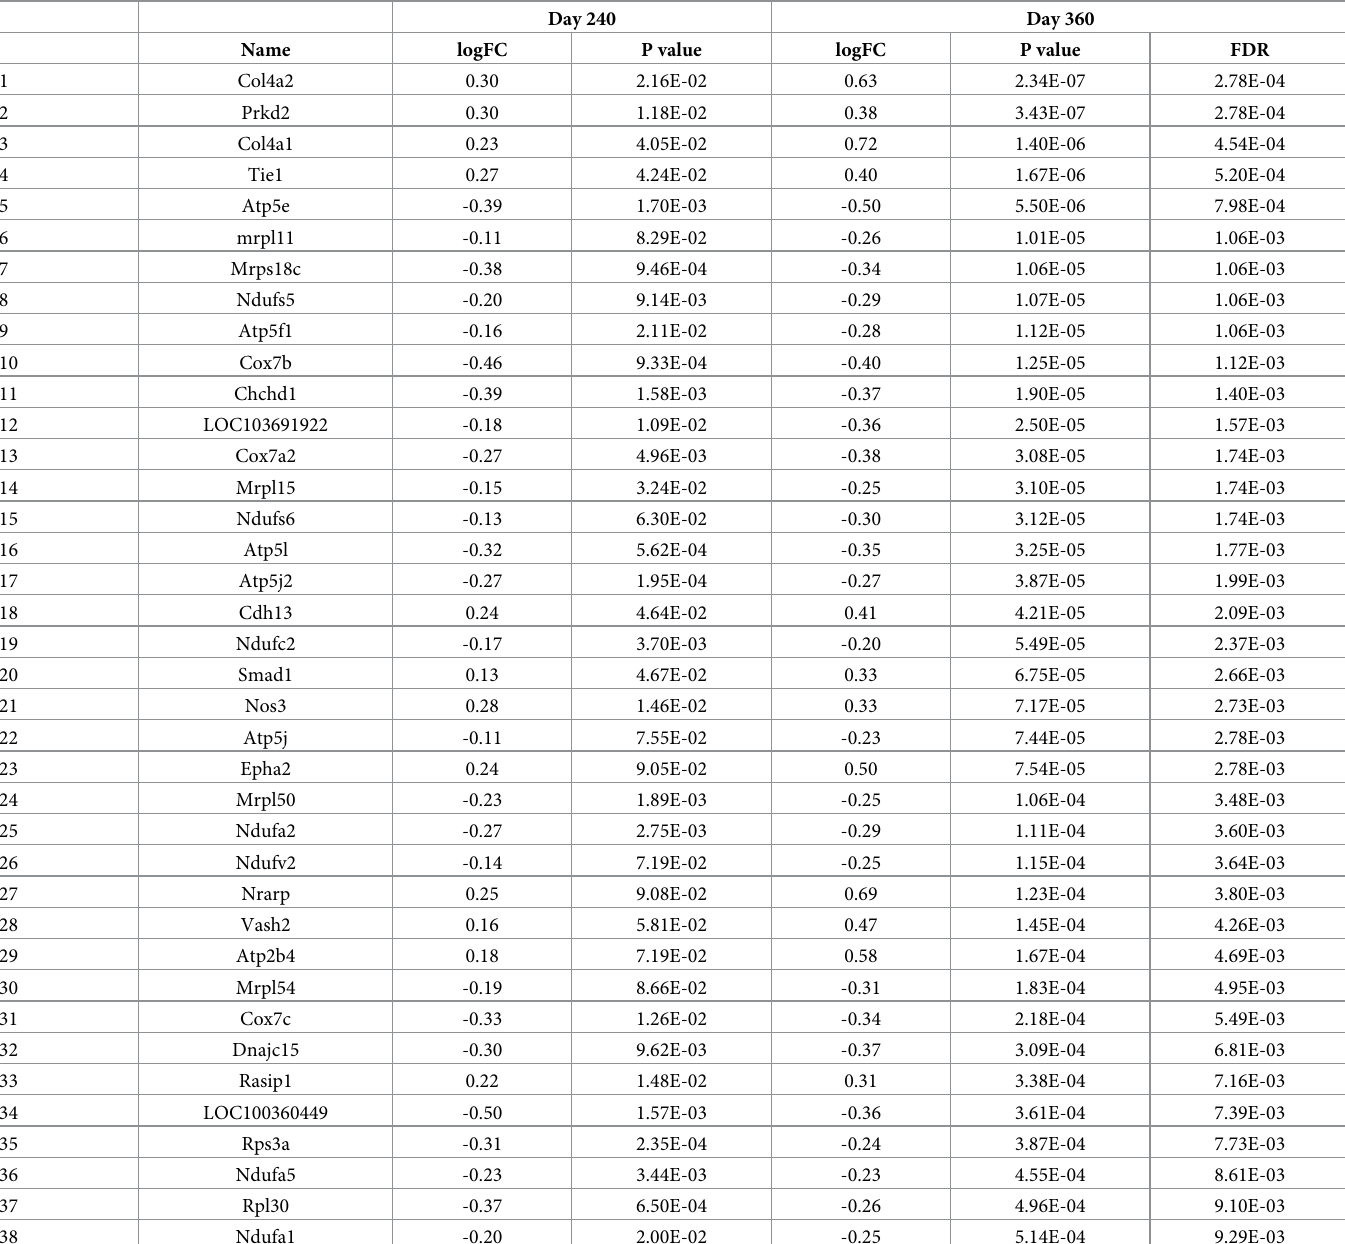
Table 6. Late onset DEG (identified at later timepoints) from significant